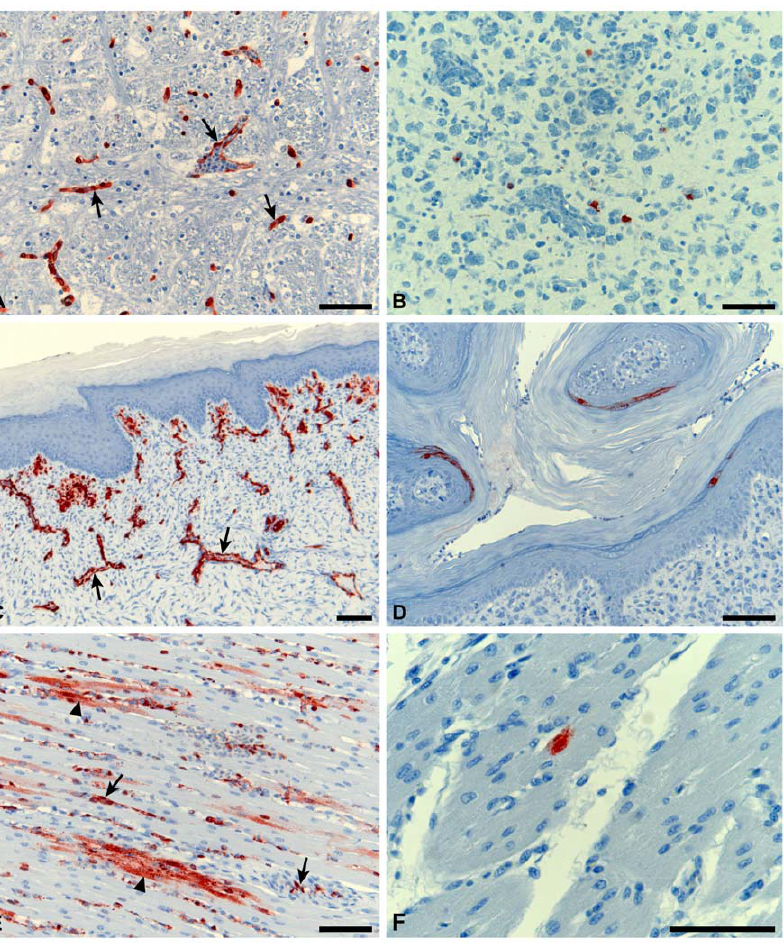
Figure 1. Virus antigen expression in tissues of infected chickens. Chickens were infected with HP VN/1203/E (A, C, E) and LP VN/1203/E (B, D, F). Tissues were taken at 18–36 hours pi from HP infected birds and at 5–13 days pi from LP infected birds. Sections were prepared from brain (A, B), skin from the comb (B, C) and heart (E, F) and stained for the presence of viral antigen. A. Brain, showing high levels of antigen in capillaries (arrows) and in occasional neurons. B. Brain, 13 days pi, showing antigen in neurons within a focus of glial proliferation. C. Skin of comb, showing antigen in capillaries (arrows) and surrounding connective tissue within the dermis. D. Skin of comb, 13 days pi, showing viral antigen in the stratum granulosum. E. Heart, showing antigen predominantly in capillaries (arrows) and in the myocardium (indicated by arrow heads). F. Heart, 5 days pi, showing viral antigen in a single myocardial fiber. All scale bars are 100 m m.